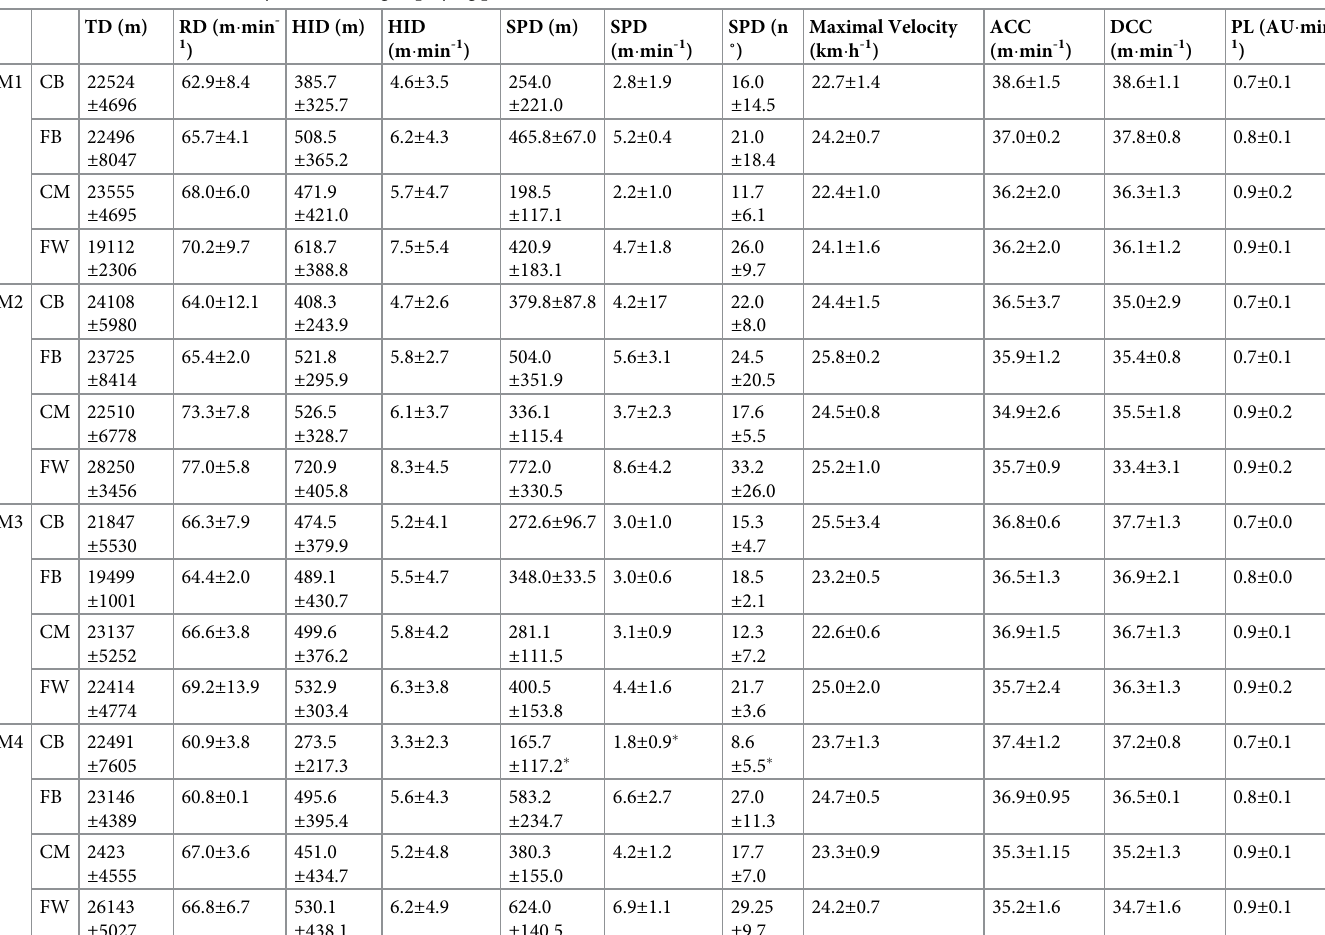
Table 3. External load in microcycles according to playing